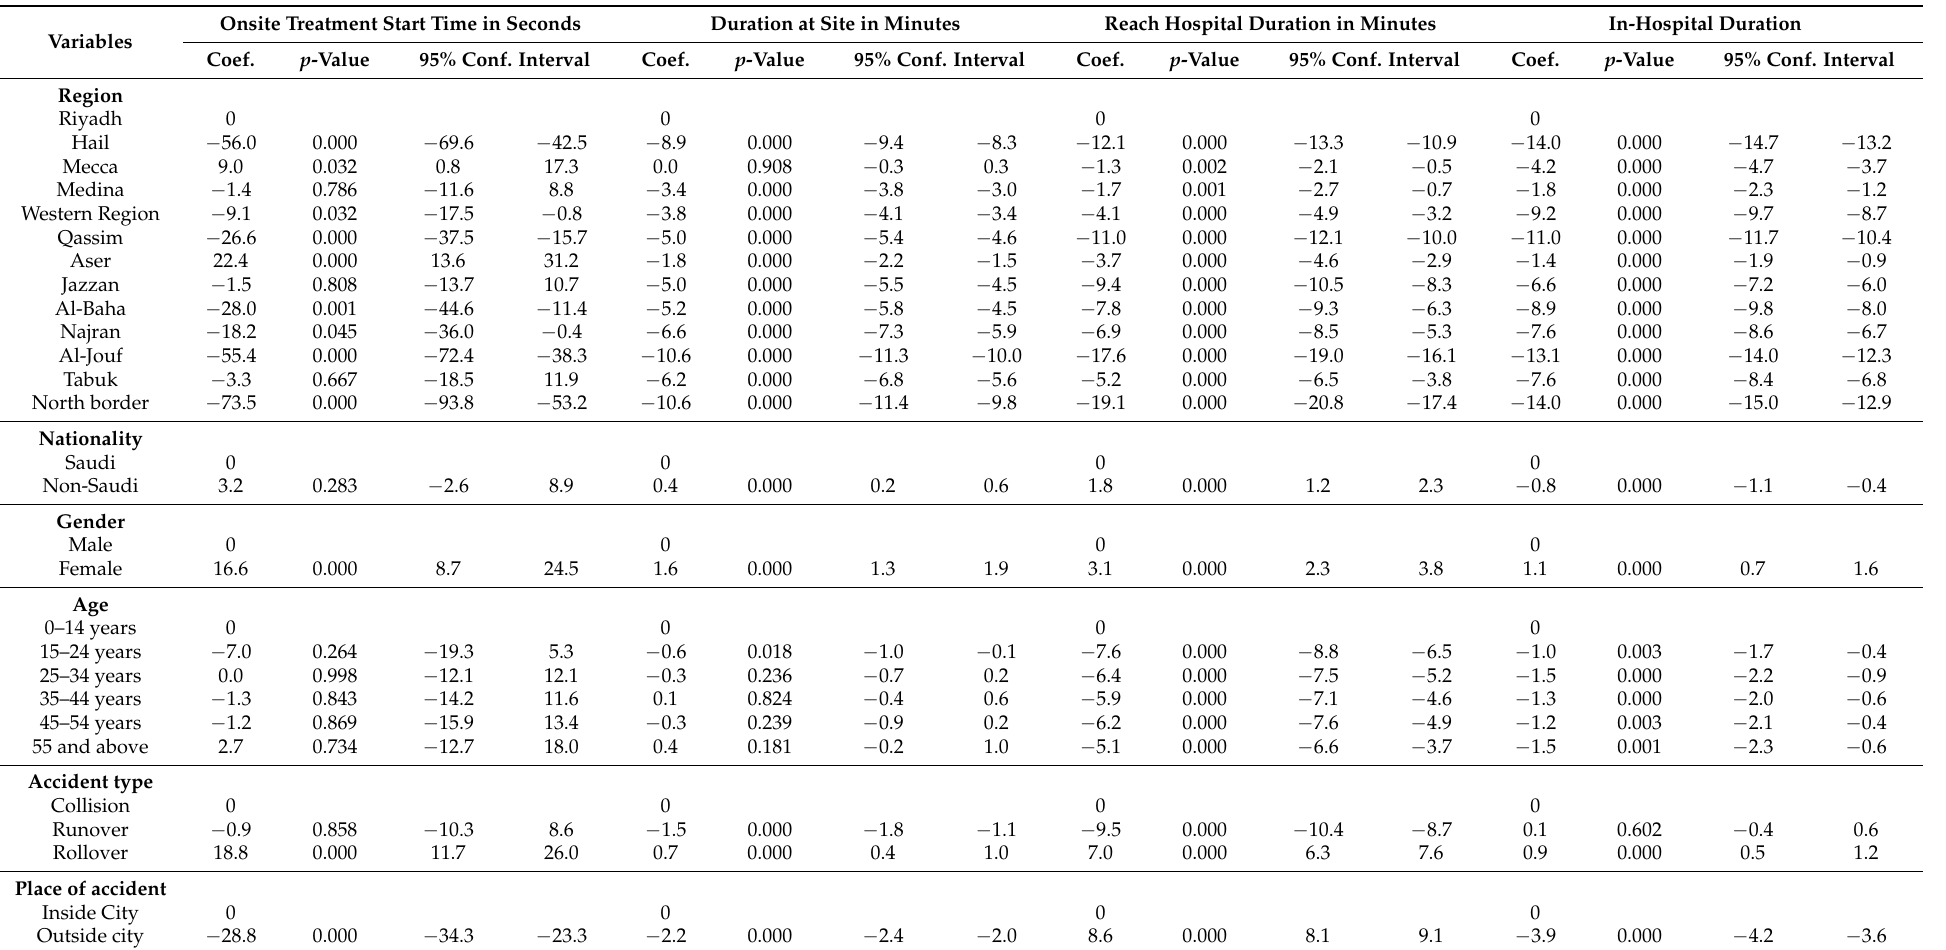
Table 4. Predictors of SRCA’s response time to road traffic accidents in the